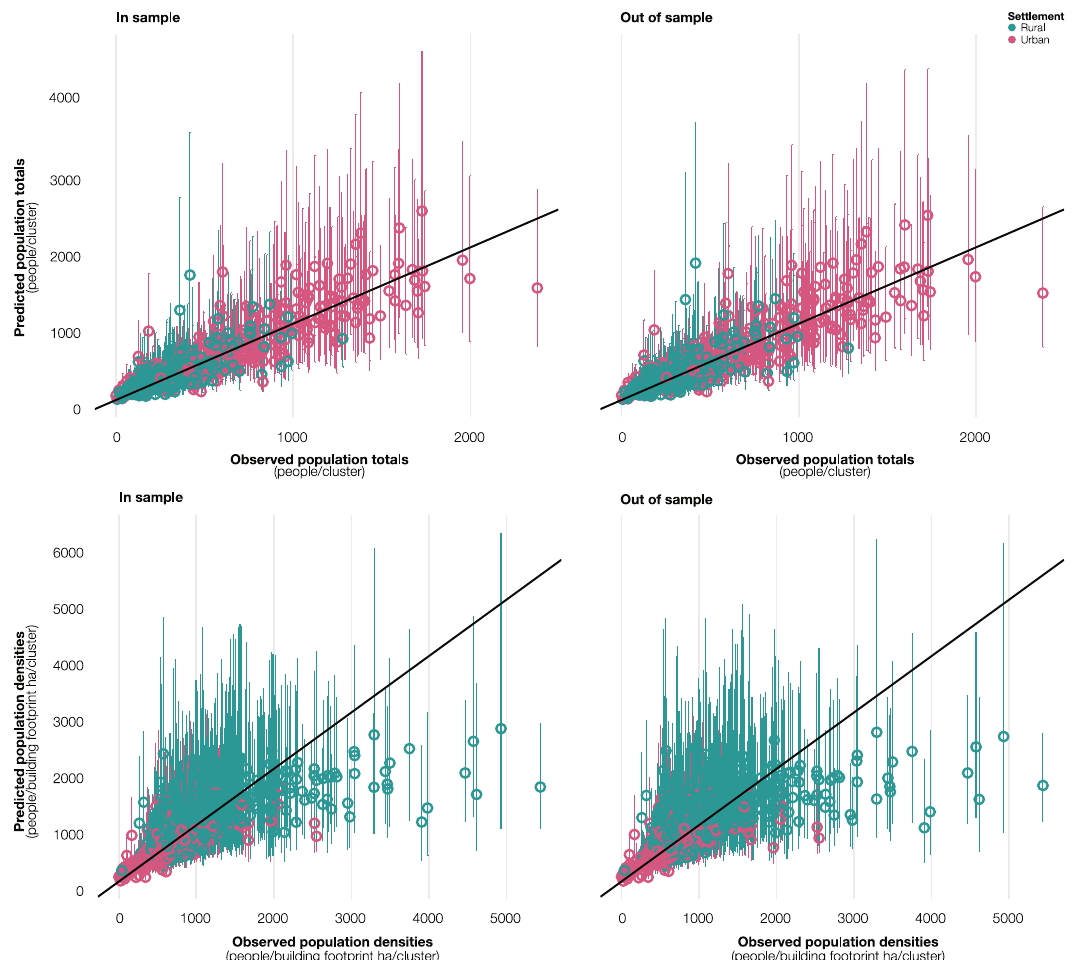
Fig. 6 Predicted versus observed population totals and densities. Observed population totals (people/cluster) and densities (people/building footprint ha/cluster) versus in-sample and out-of-sample mean posterior predictions (colored dots) with 95% credible intervals (colored vertical lines) derived from the respective posterior distribution ( n = 10,000). Population totals and densities are classi fi ed according to the settlement type (urban in pink and rural in turquoise). The diagonal black lines show a perfect relationship between observations and predictions. Source data are provided with this